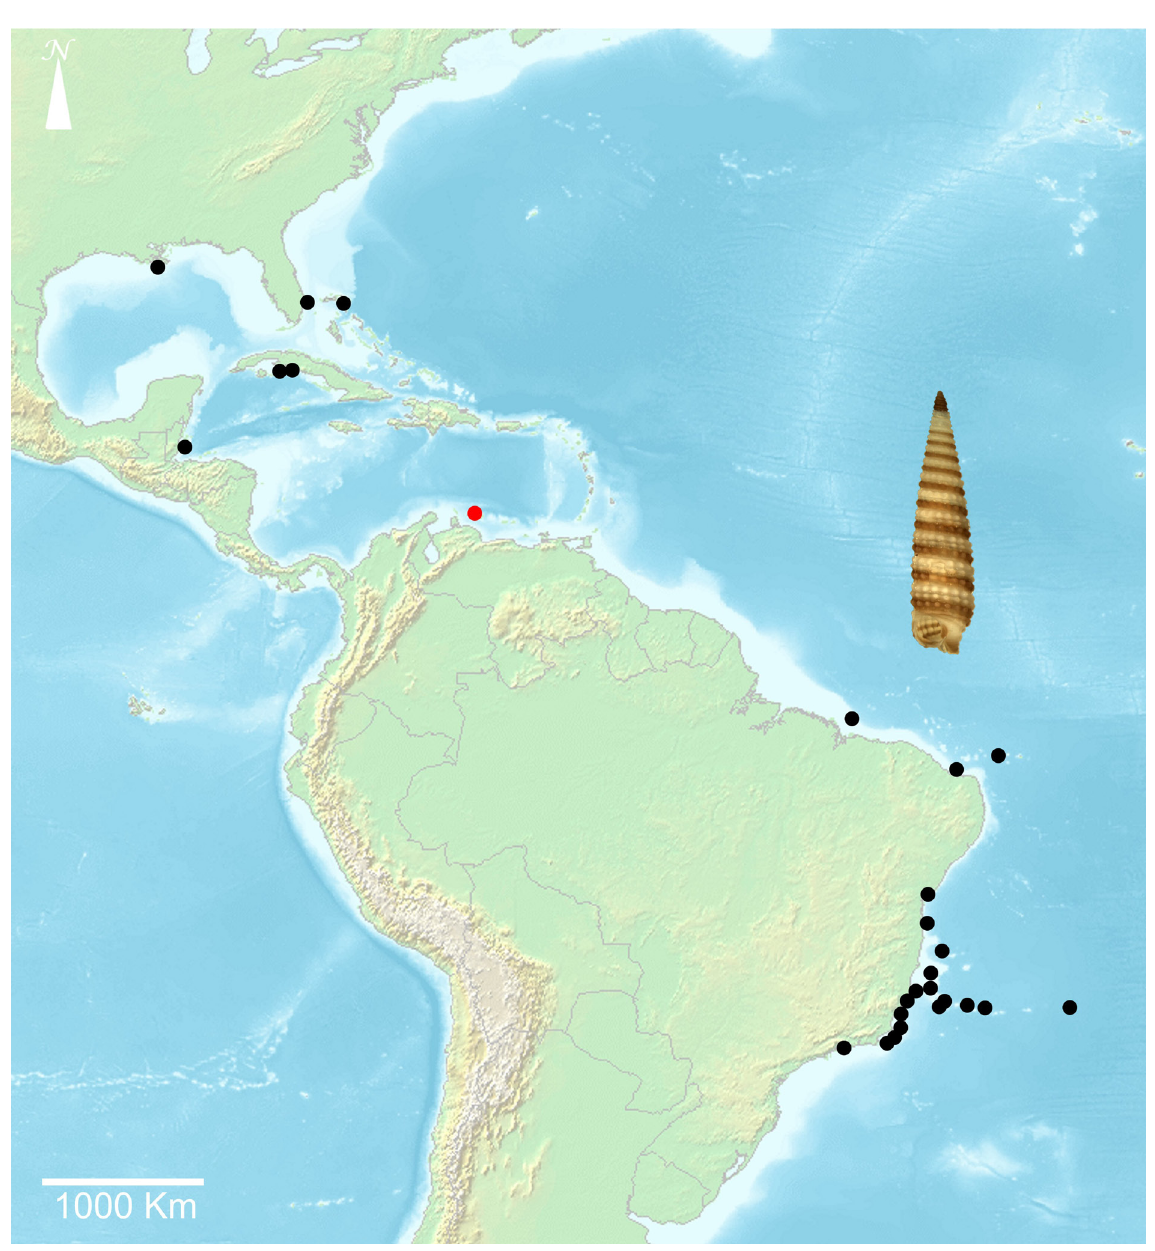
Fig. 79. Distribution map of Triphora elvirae De Jong & Coomans, 1988; red circle = type